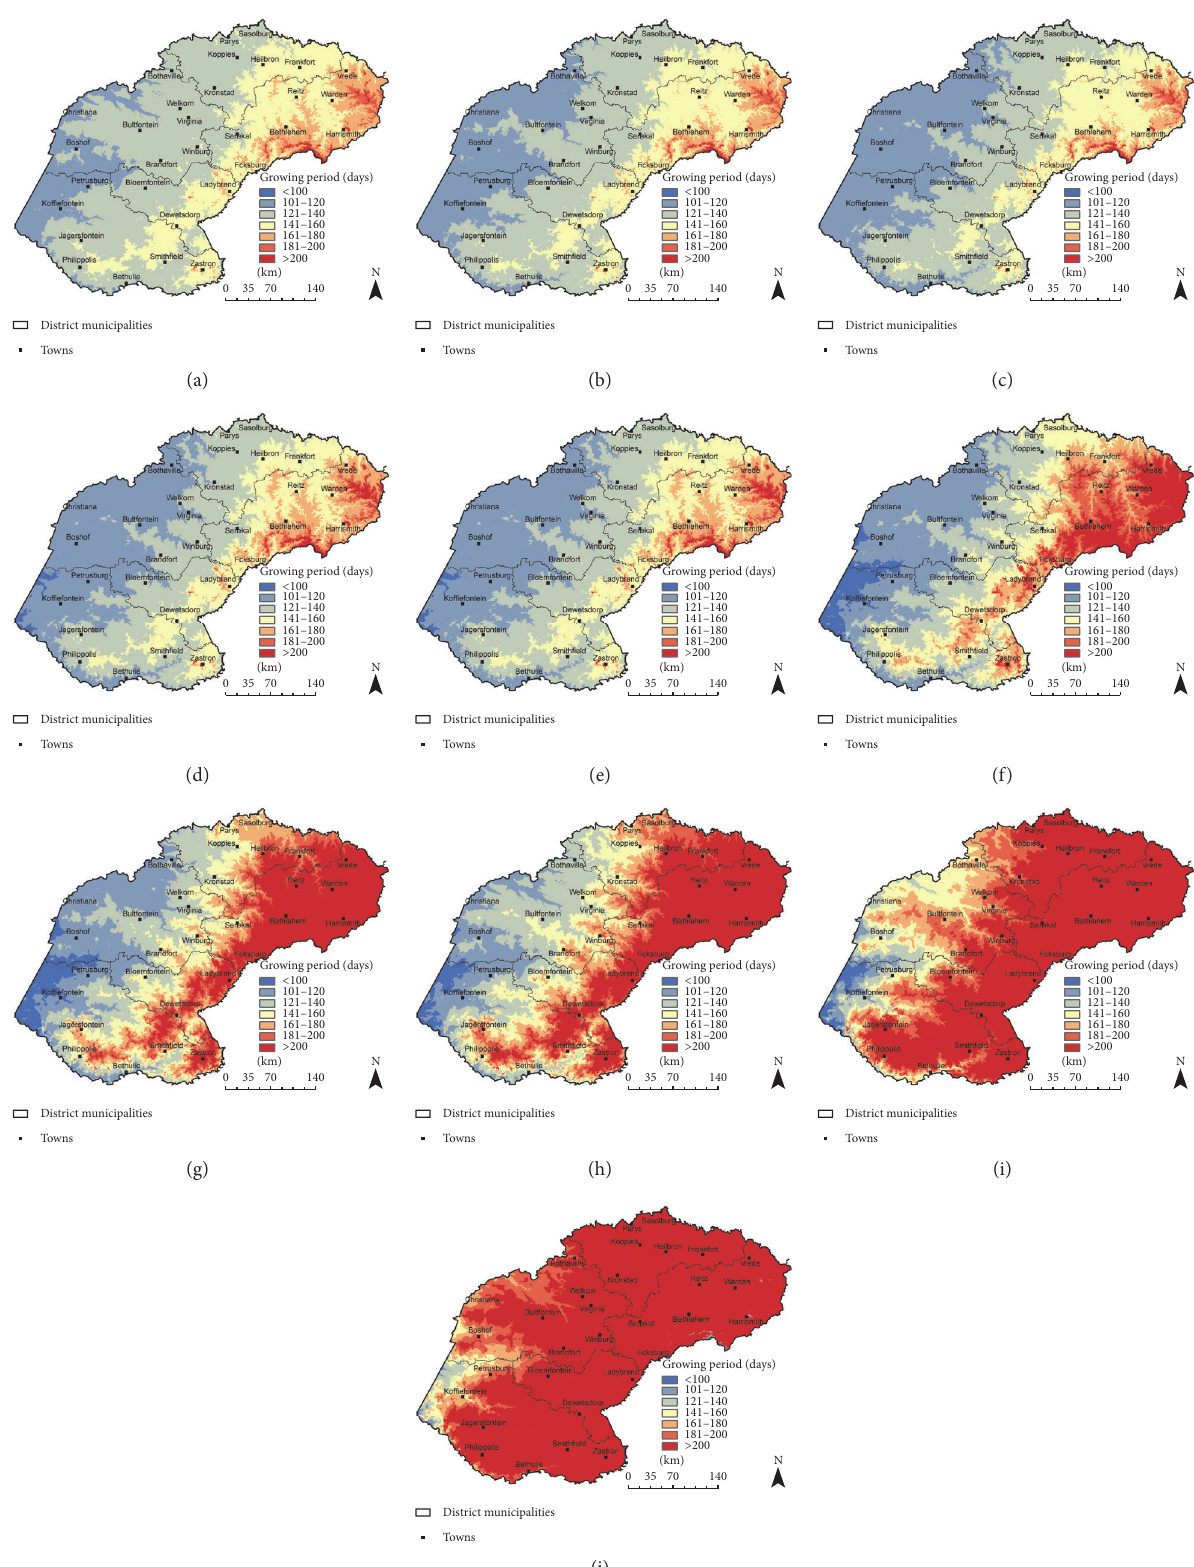
Figure4:Growingperiodindaysat50%nonexceedenceprobabilityforamediumseasonmaizevarietyplantedinthe(a)1stdekadofOctober, (b) 2nd dekad of October, (c) 3rd dekad of October, (d) 1st dekad of November, (e) 2nd dekad of November, (f) 3rd dekad of November, (g) 1st dekad of December, (h) 2nd dekad of December, (i) 3rd dekad of December, and (j) 1st dekad of